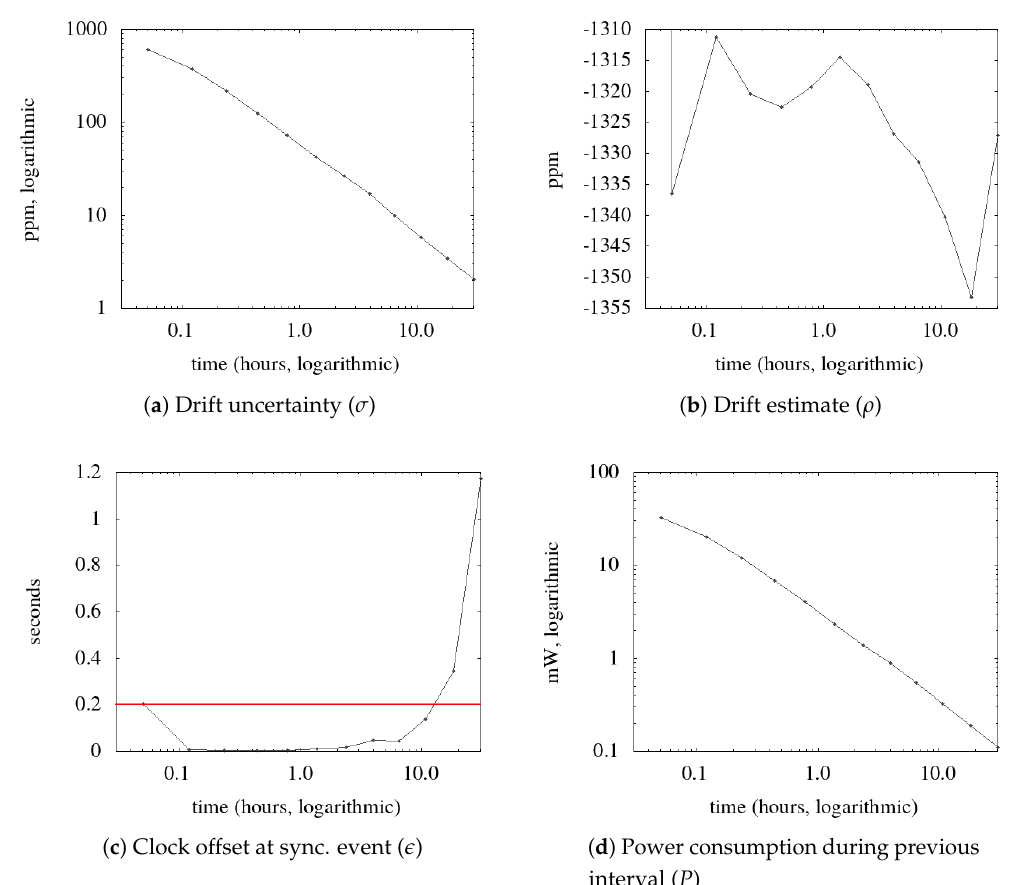
Figure 2. Results of the first experiment with an undocumented clone of the Arduino Pro Mini. Clock uncertainty ( c ) diverges and exceeds the threshold (in red), after 3 × 10 7 ms (8 h). The reason is that drift variation ( b ) during such periods exceeds drift uncertainty ( a ), which is higher than 10ppm because of clock